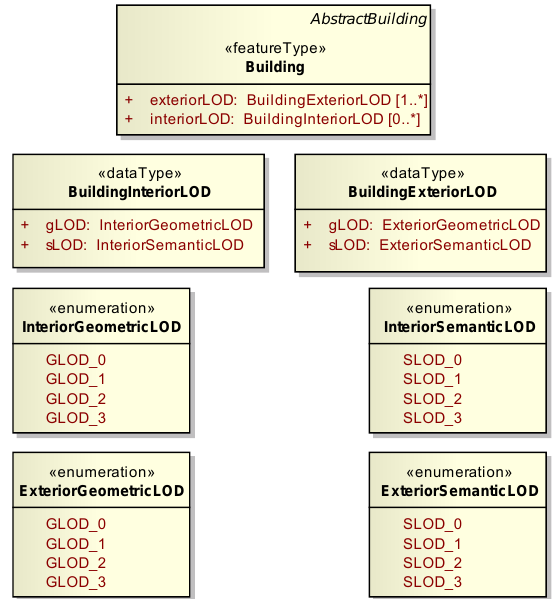
Figure 8: Metadata of Building